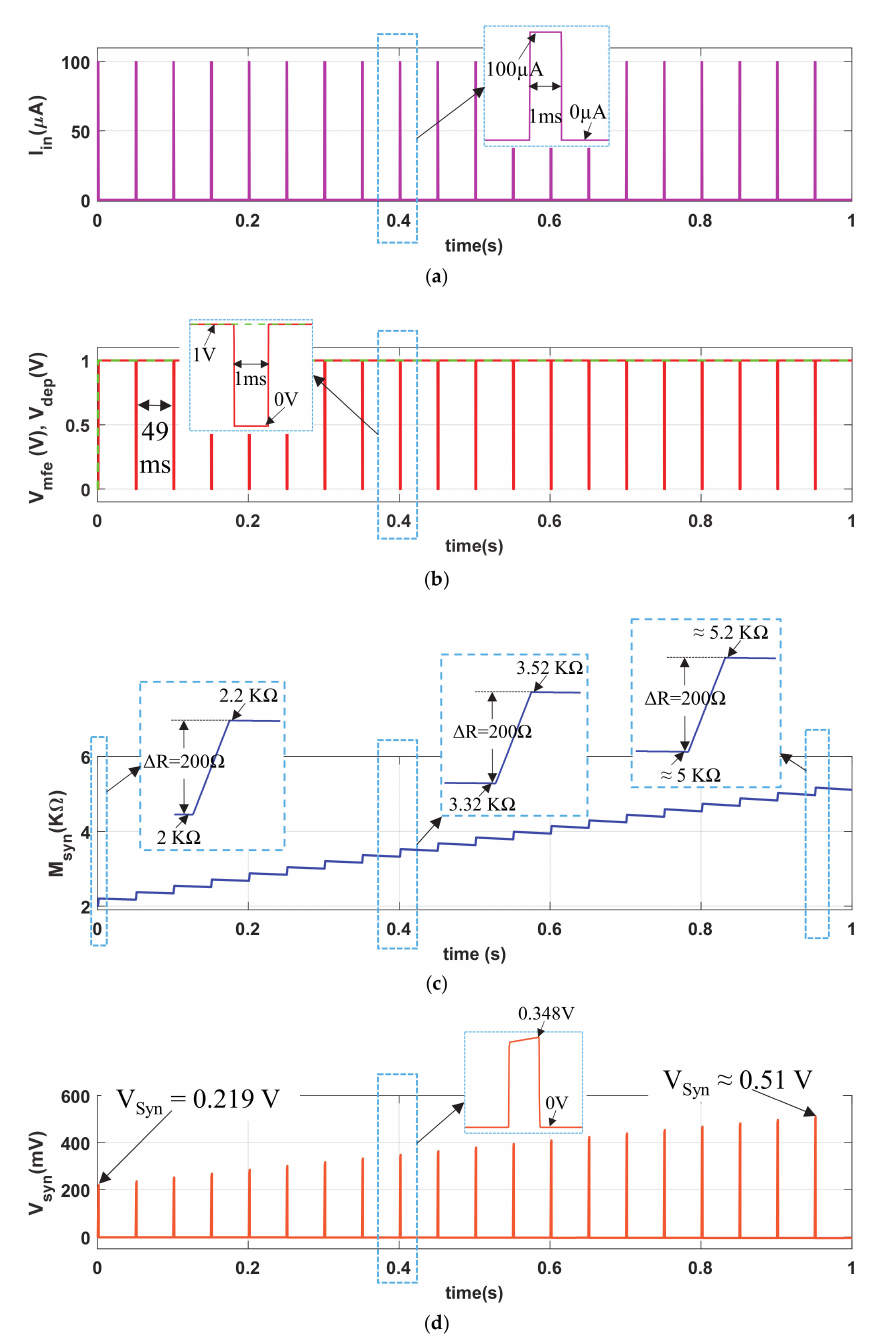
Figure 3. Normal synaptic response (NSR) of the proposed memristive synapse: ( a ) current stimulus (I in ), ( b ) memory fading effect (V mfe ) and depression (V DEP ) signals, artificial ( c ) synaptic strength (M syn ), and ( d ) synaptic voltage (V syn